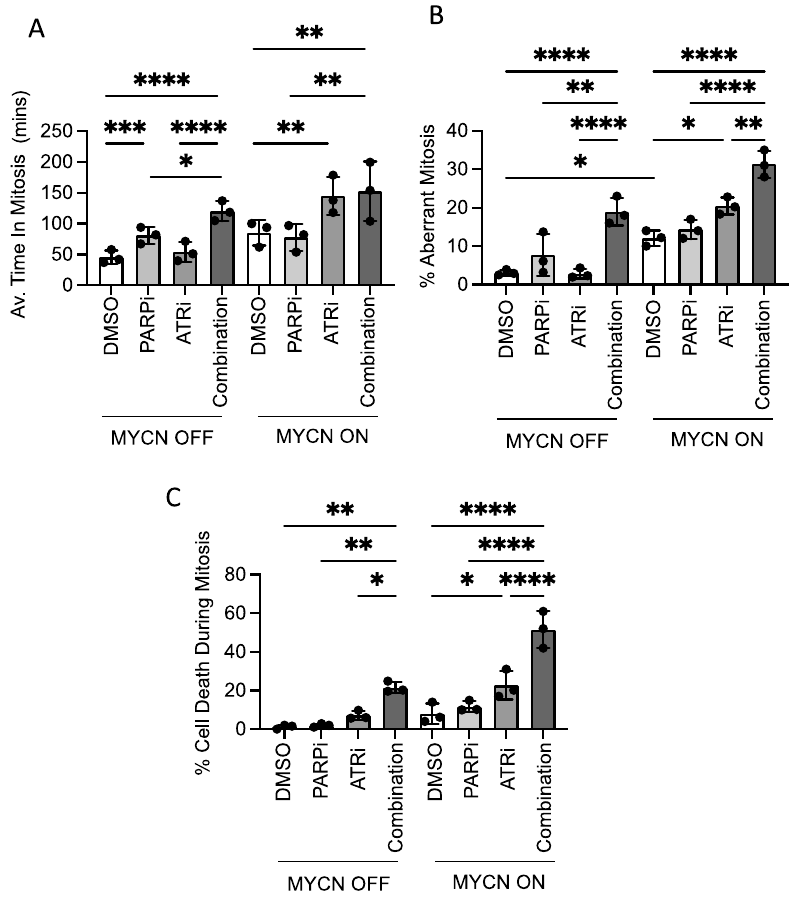
Figure 6. ATRi in combination with MYCN expression or PARPi results in increased mitotic aberrance, increased time in mitosis and increased cell death. Live cell imaging recorded over 12 h, starting 24 h post-treatment of SHEP-Tet21/N cells with MYCN ON and MYCN OFF with 0.5 µM